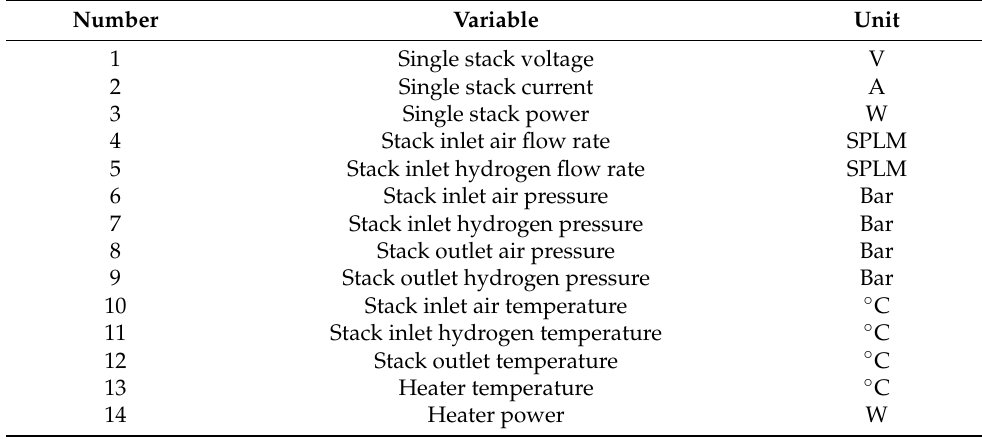
Table 2. Variables monitored by the PEMFC test system.